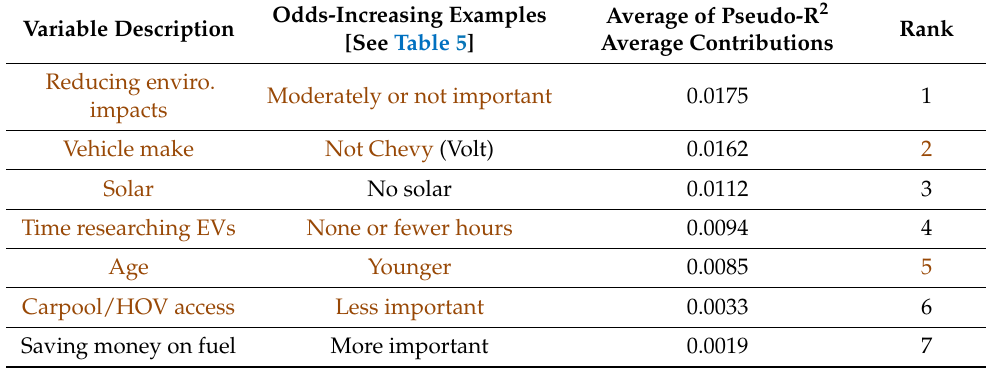
Table 7. Summary and Rank-Ordering of Key PHEV Convert Predictors (Dominance Analysis).